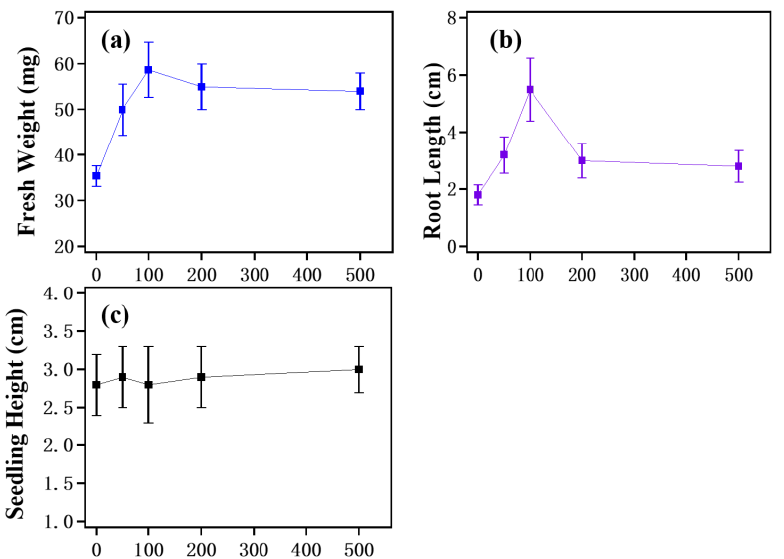
Figure 4. Fresh weight ( a ), root length ( b ) and seedling height ( c ) of camphor seeds germinated after soaking with different concentrations of rod-like TiO 2 .